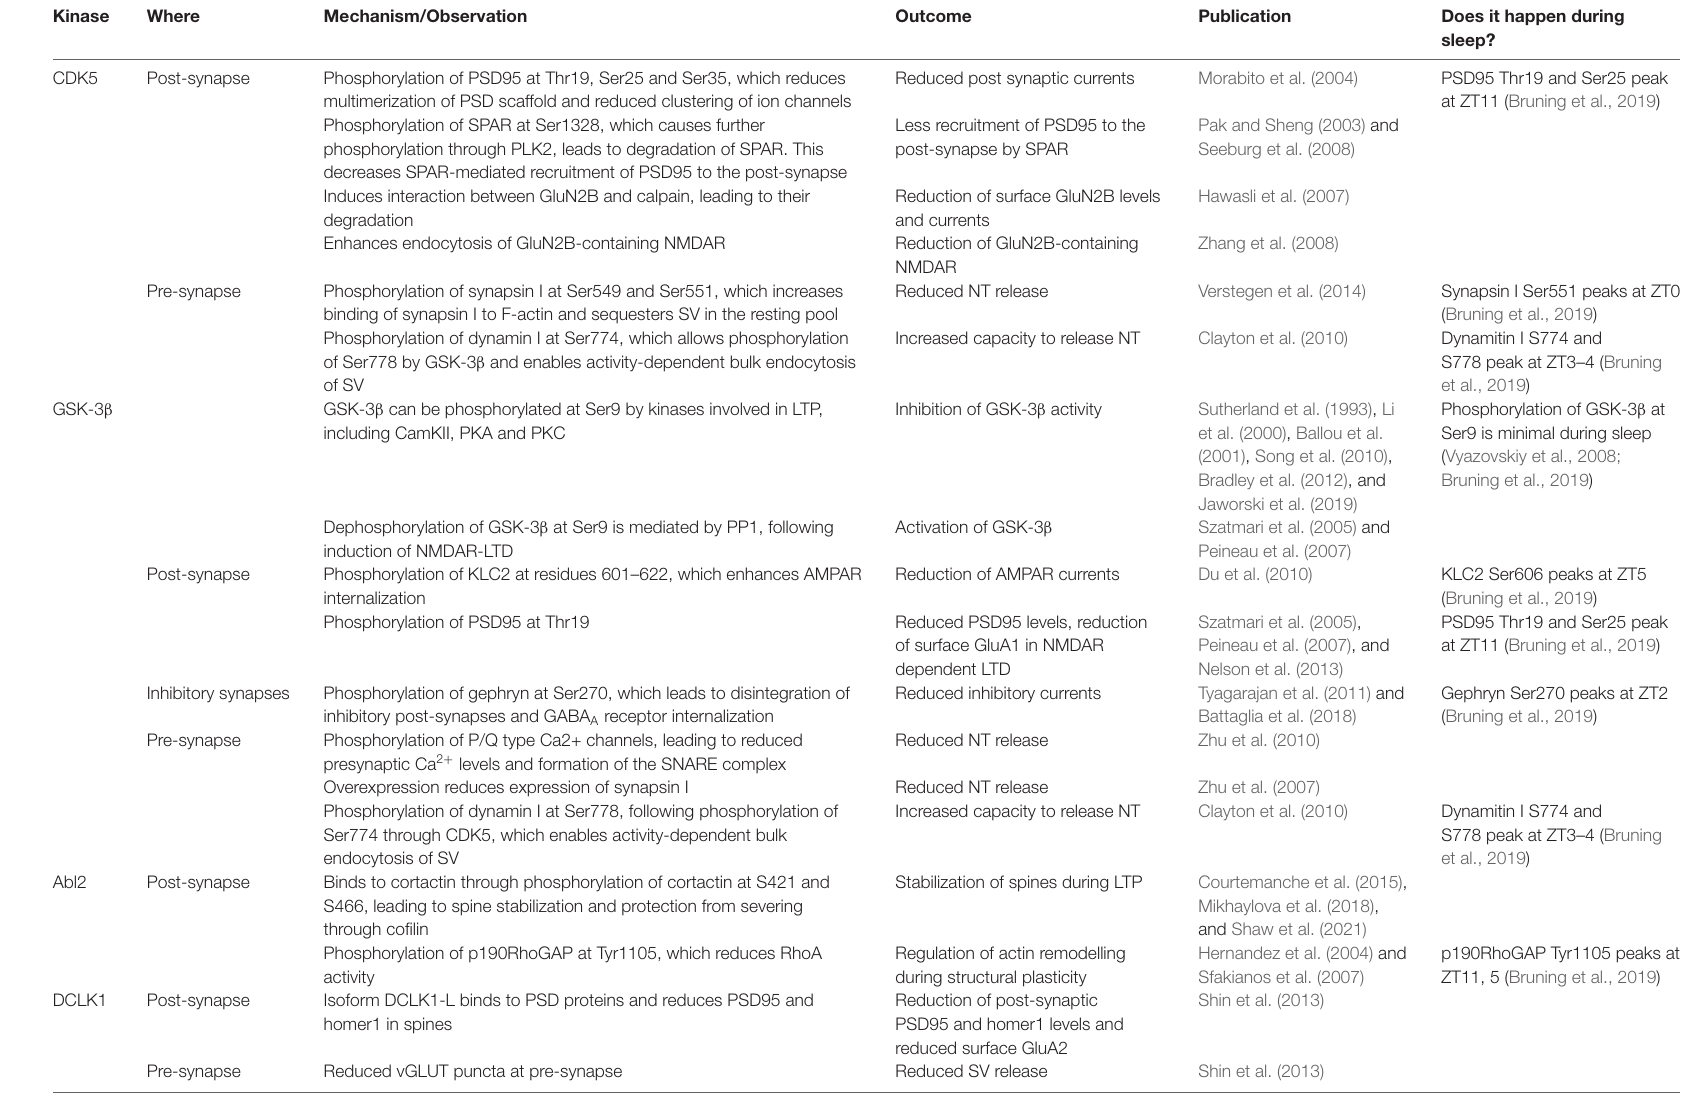
TABLE 1 | The effects of the kinases CDK5, GSK-3 β , Abl2, and DCLK2 on synaptic plasticity and evidence for their action during sleep. Kinase